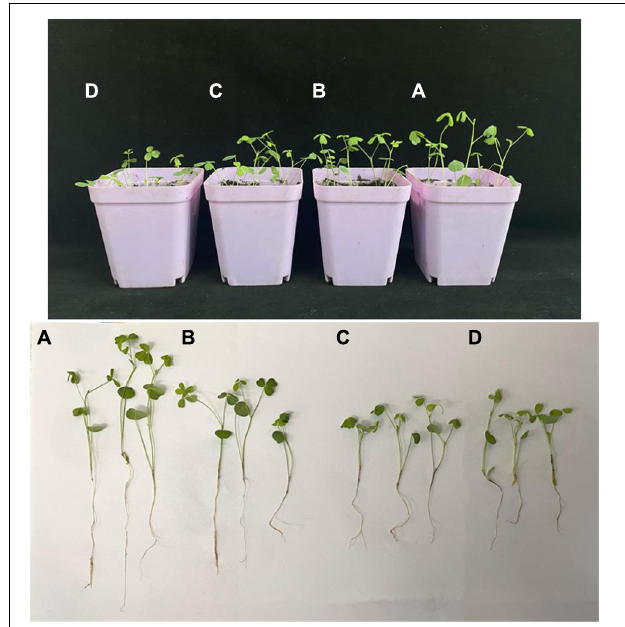
FIGURE 7 | Effect of p-coumaric acid on alfalfa seedling and root rot. (A) Inoculated with water as control. (B) Inoculated with mixed spore suspensions of Fusarium tricinctum , F. acuminatum , and F. oxysporum . (C) Inoculated with mixed spore suspensions of the three Fusarium spp. and 10 µ g/mL p-coumaric acid. (D) Inoculated with mixed spore suspensions of the three Fusarium spp. and 50 µ g/mL p-coumaric